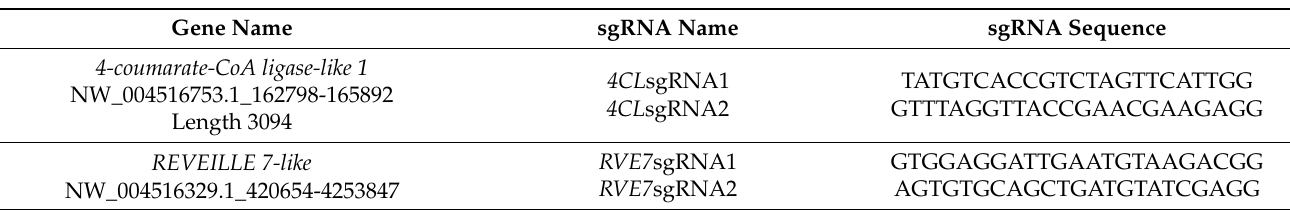
Table 2. List of sgRNAs designed to target 4CL and RVE7 genes in chickpea. A 20 bp sequence of crRNA/tracrRNA with PAM in